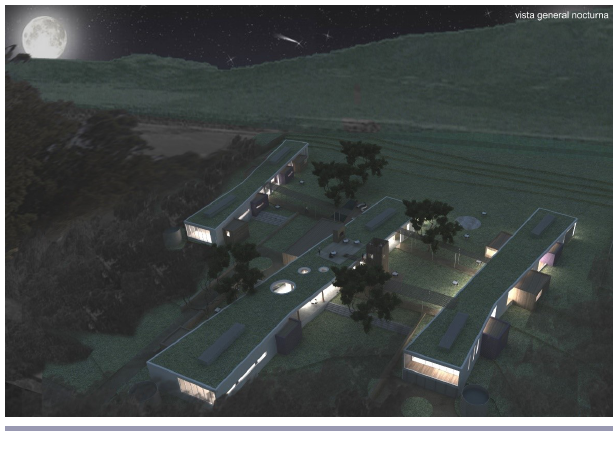
Fig. 1. Artist’s impression of the three main buildings at night.